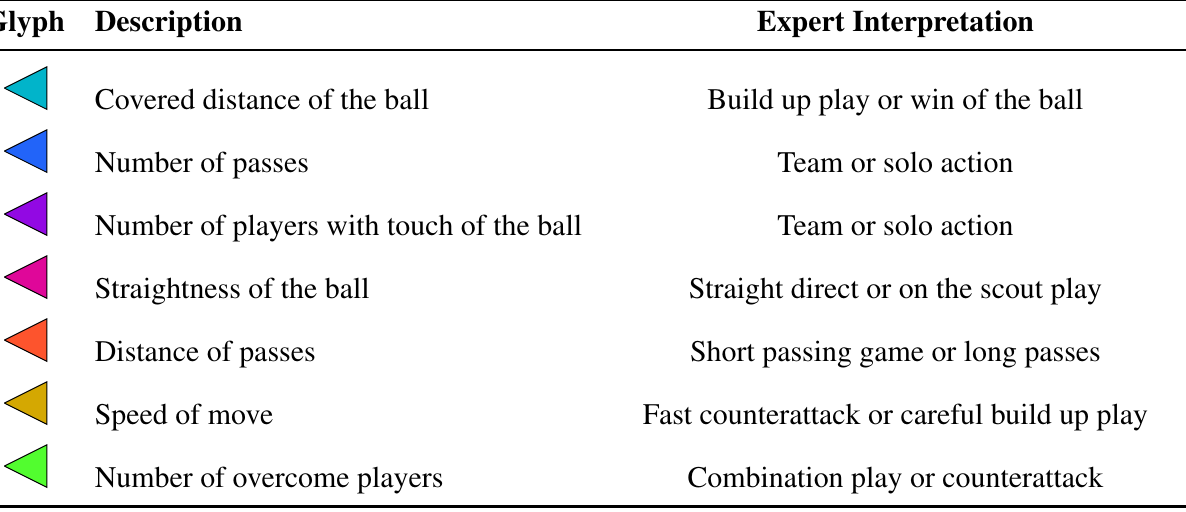
Table 1. Descriptions of the semantically-meaningful features introduced. The